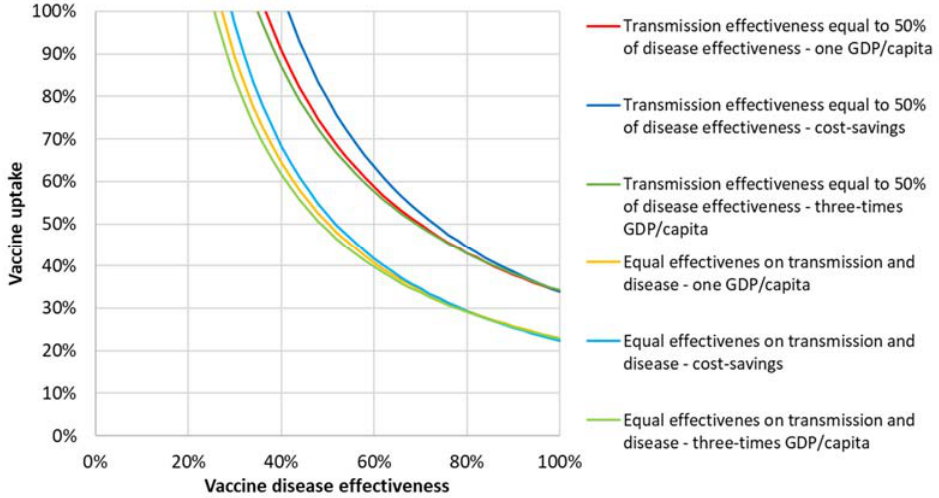
Figure 9. Iso-ICER cost-effectiveness curves at various thresholds for vaccine transmission effectiveness equal to 50% of disease effectiveness and equal effectiveness on transmission and disease.